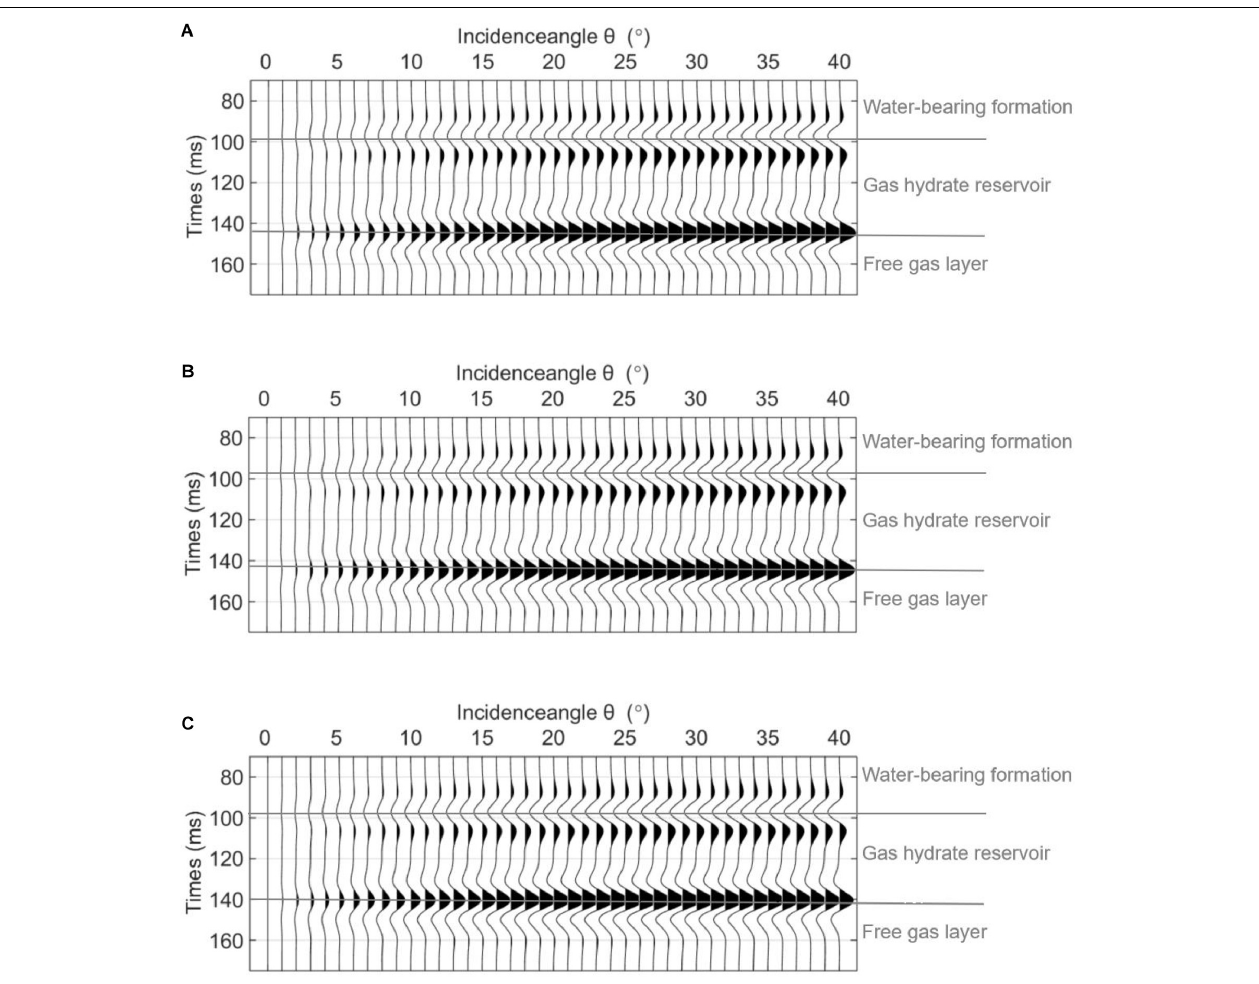
FIGURE 10 | The mode-converted PS AVO for different hydrate saturations S. (A) S = 0.2, (B) S = 0.35, and (C) S = 0.5.